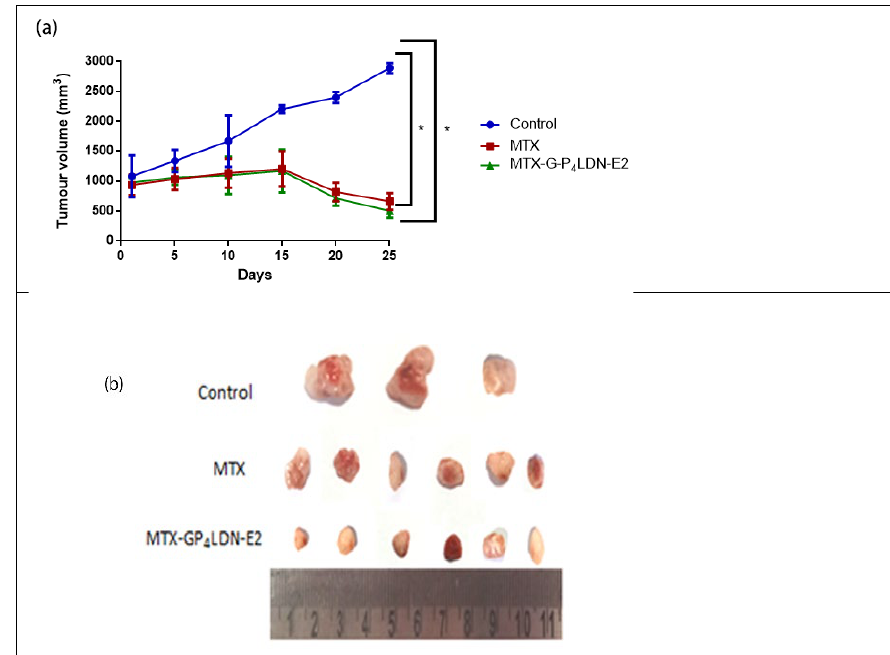
Figure 10. ( a ) Anti-tumor efficacy of MTX (20 mg/kg) and MTX–G–P 4 LDN–E2 (35 mg/kg) in fe- male NOD-SCID mice ( n = 3 for the control group, n = 6 for MTX, and n = 6 for MTX–G–P 4 LDN– E2). Data are represented as the arithmetic mean ± SD, and one-way ANOVA followed by Dun- nett’s test were performed for statistical analysis (* p < 0.005). ( b ) Comparison of tumor volumes